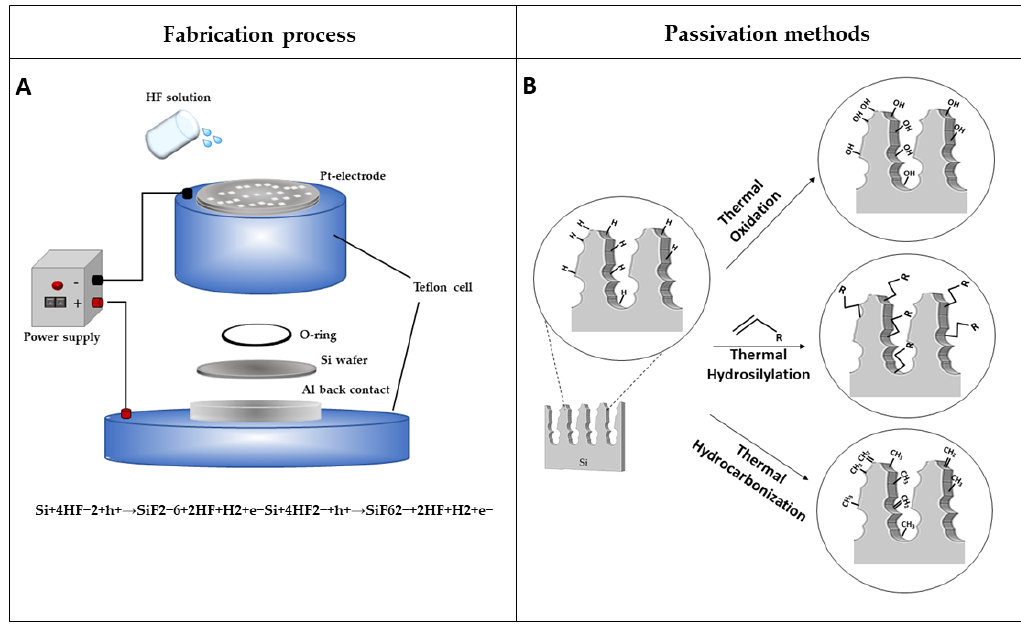
Figure 1. ( A ) Electrochemical etching setup; and ( B ) passivation strategies to stabilize PSi surfaces.